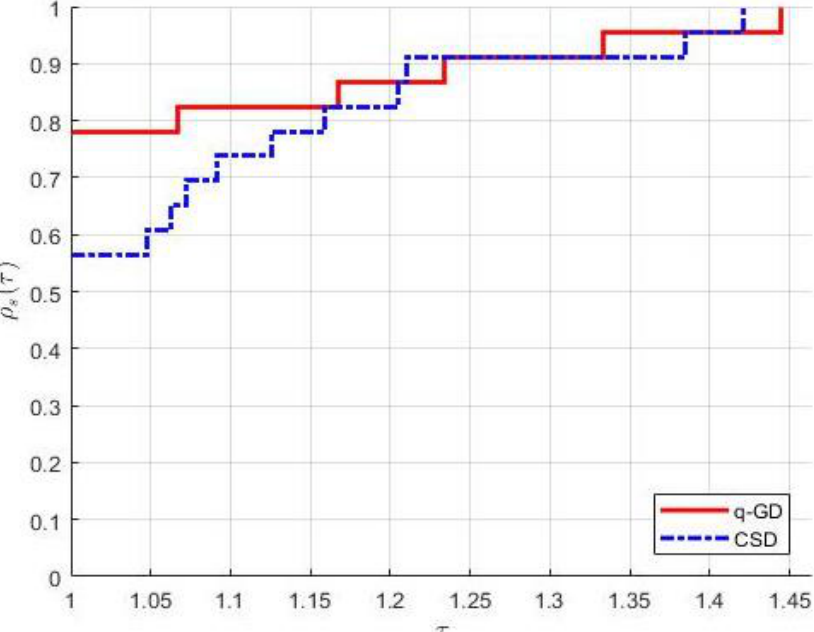
Figure 3. Performance profile for number of function evaluations based on Table